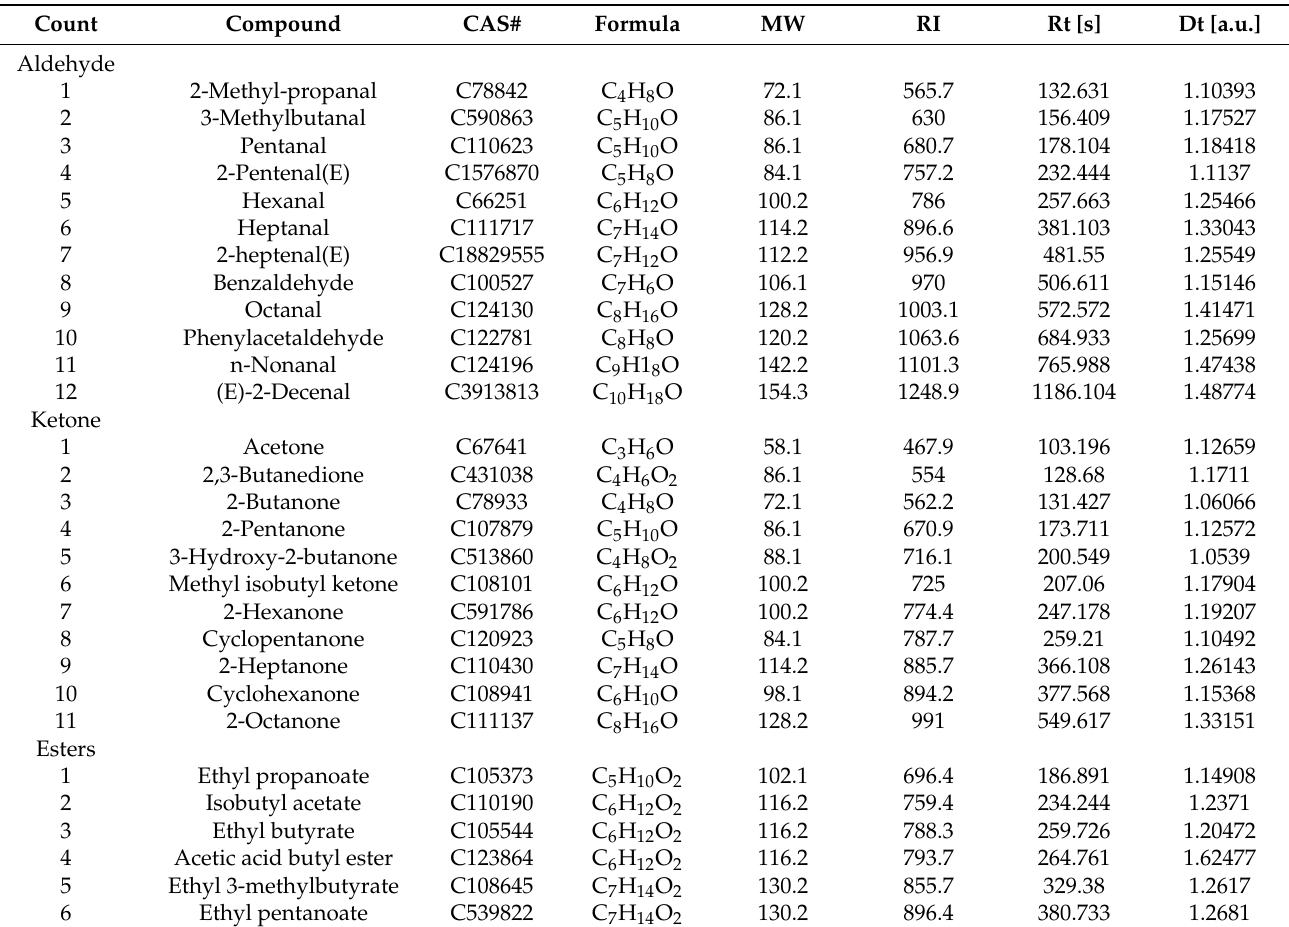
Table 3. GC-IMS compound